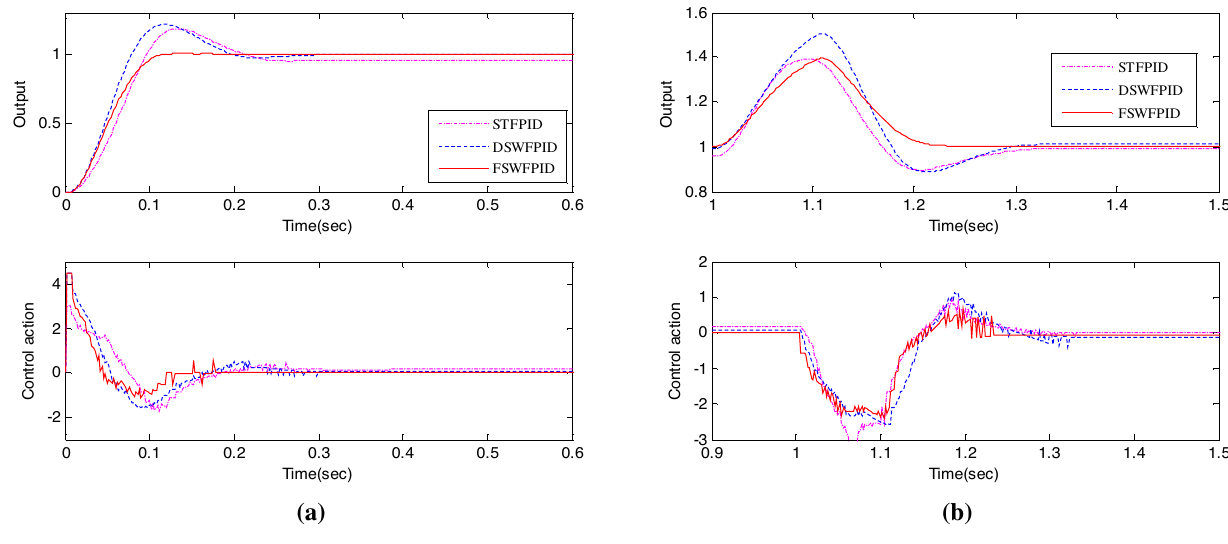
Fig. 25 Responses and control actions for Quanser QUBE-Servo 2 using 49 rules during a set point tracking and b load